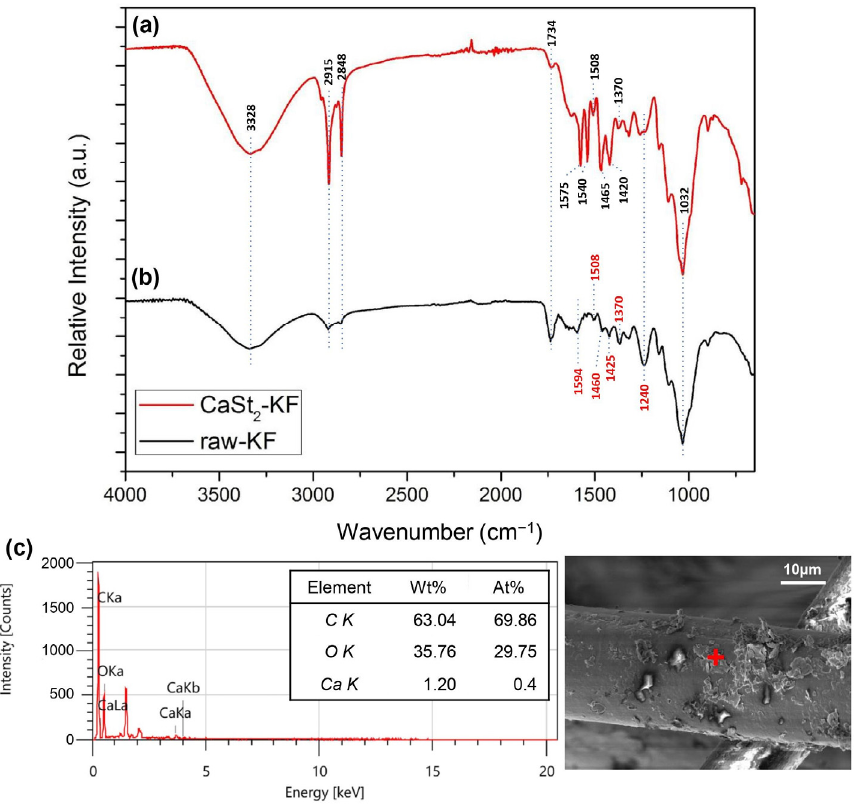
Figure 4. (Color online) FTIR spectra of ( a ) CaSt 2 -KF and ( b ) raw-KF, and ( c ) EDX spectra of CaSt 2 -KF (‘ + ’ is the point of analysis).